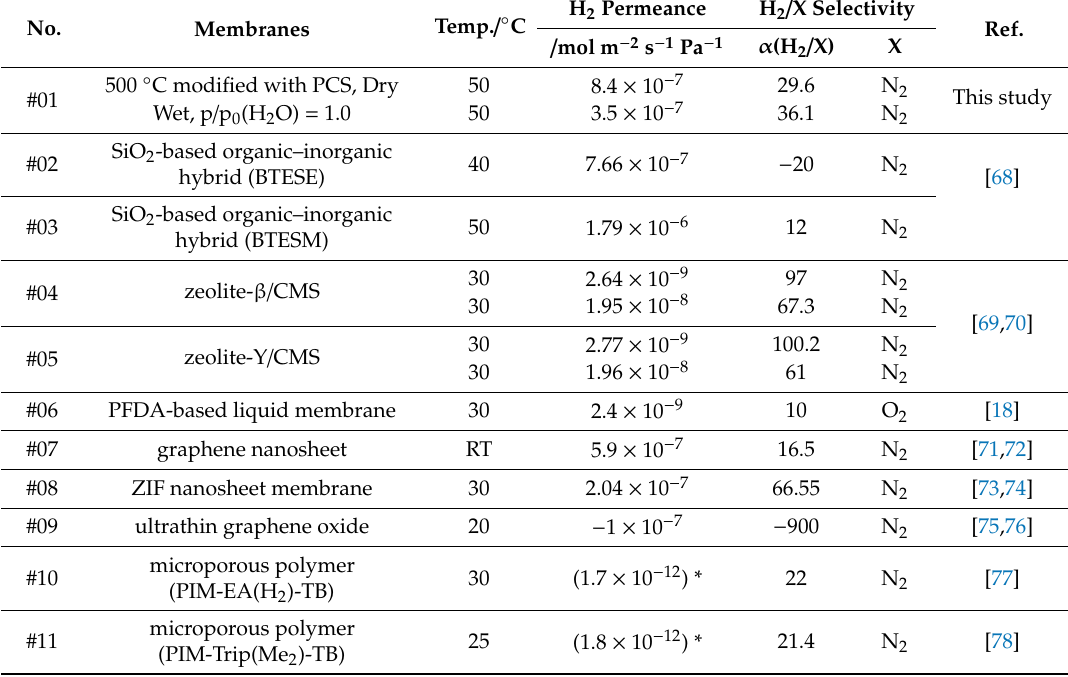
Table 3. H 2 -permselectivities of composite membrane in this study and those of other membranes evaluated at T ≤ 50 ◦ C under the dry